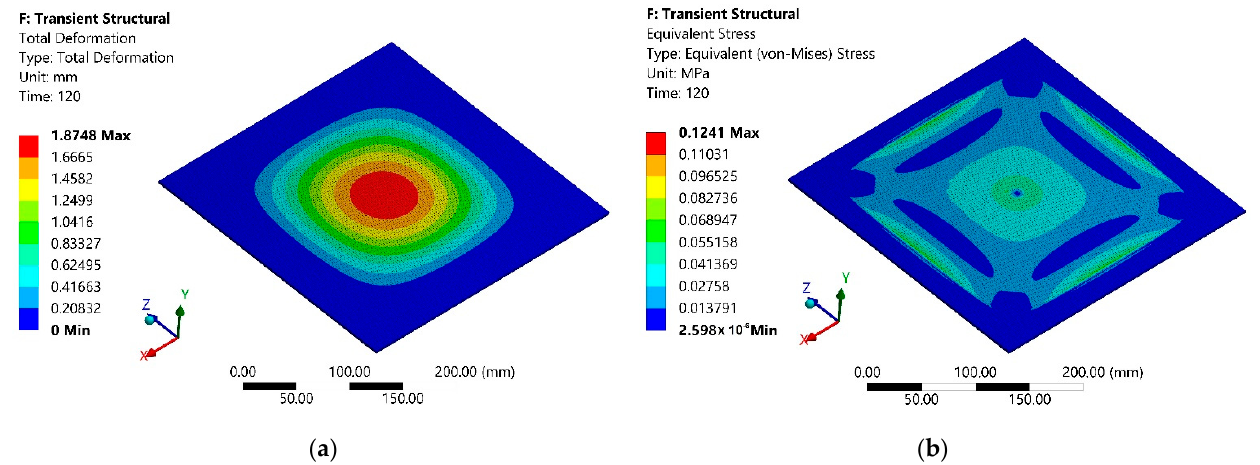
Figure 13. Modeling results of the second stage after 120s from the start of heating: ( a ) total deformation; ( b ) equivalent Von Mises stress.